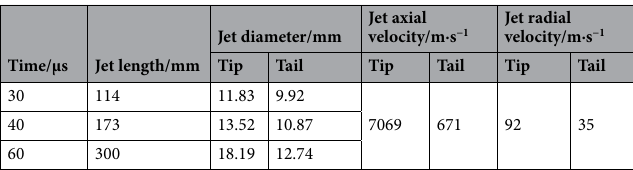
Table 1. Jet experimental